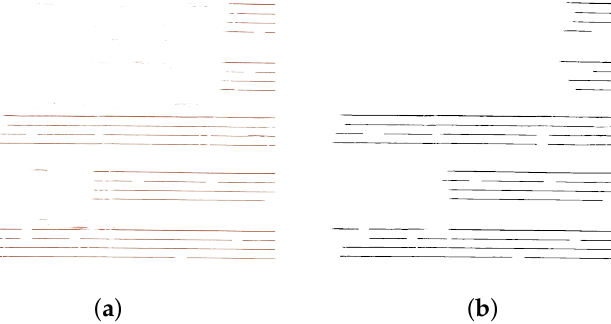
Figure 3. Image detail of folio 1r of Salzinnes book illustrating the application of the binarization and cleaning stages. ( a ) Input image. ( b ) Image after the pre-processing stage.